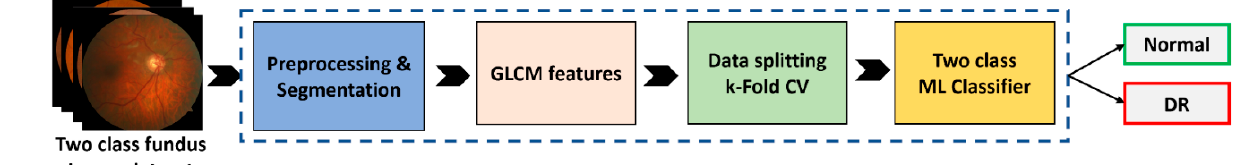
Figure 3. An overview of the proposed DR classifier.